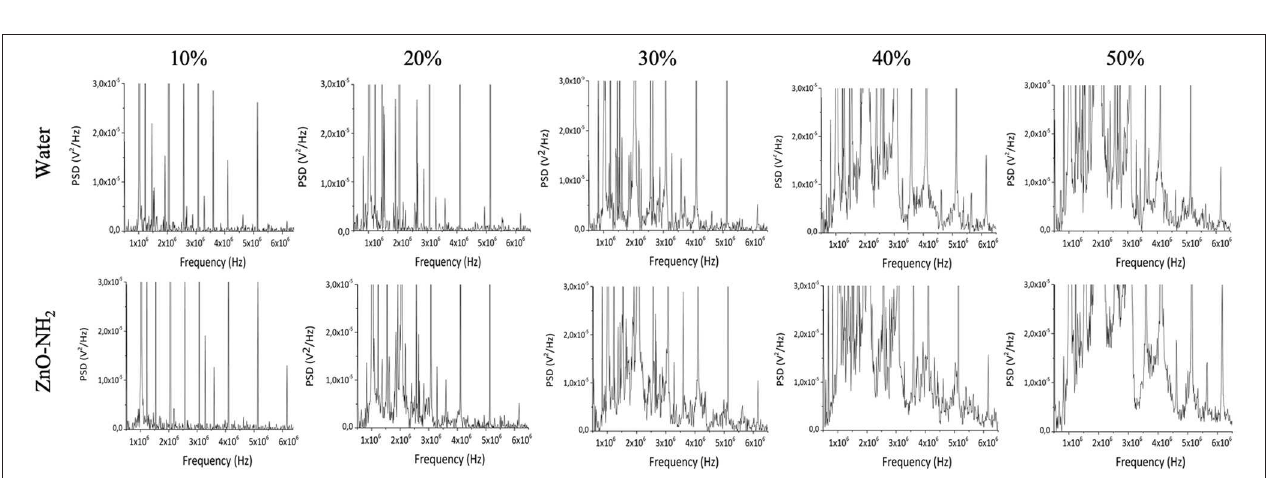
FIGURE 4 | (A) Effects on ROS production at different concentration of ZnO-NH 2 NC; measurements were conducted in duplicate with 10% DC, 0.9 W/cm 2 , 10min of treatment time, 1 MHz. One-way ANOVA was performed to determine statistical significance (* p < 0.05 and ** p < 0.001). (B) Evaluation of the optimal amount of treatment time, with 10% DC, 0.9 W/cm 2 , 1 MHz, and 200 µ g/ml of ZnO NC. (C) Comparison between different excitation frequency for all the tested US power, with 10% of DC, 10min as treatment and time 200 µ g/ml of ZnO NC.